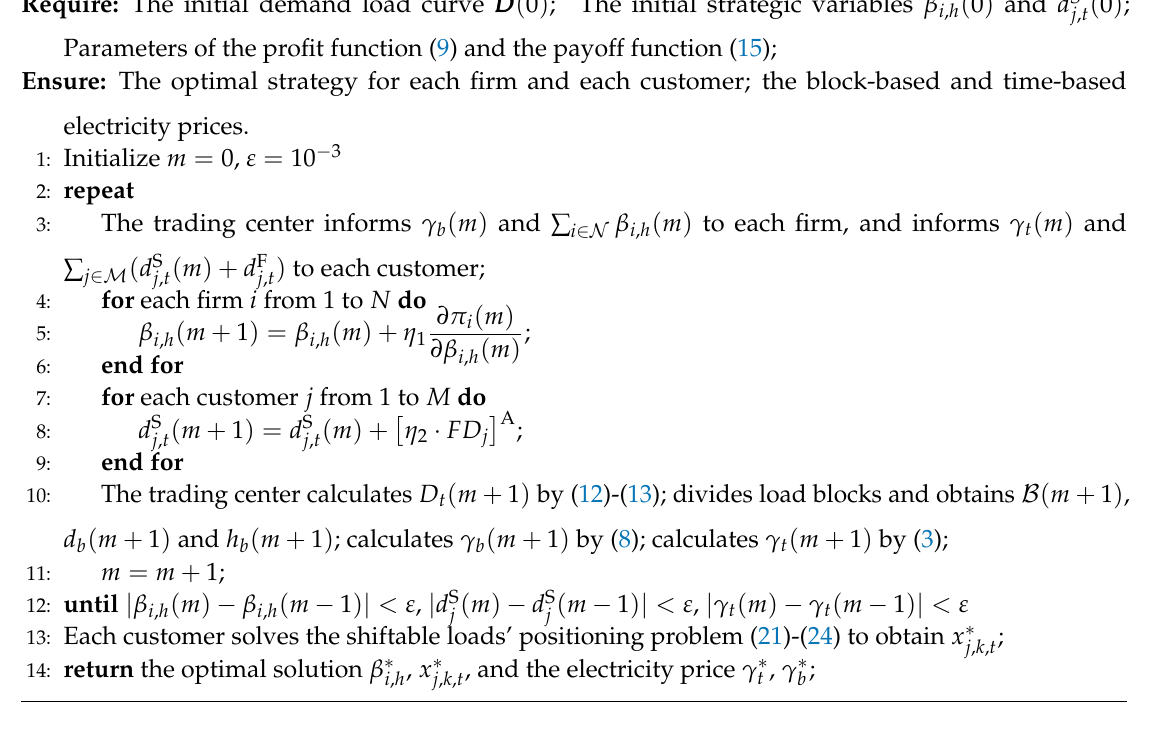
Algorithm 1 Distributed iterative algorithm of the double-sided non-cooperative game.